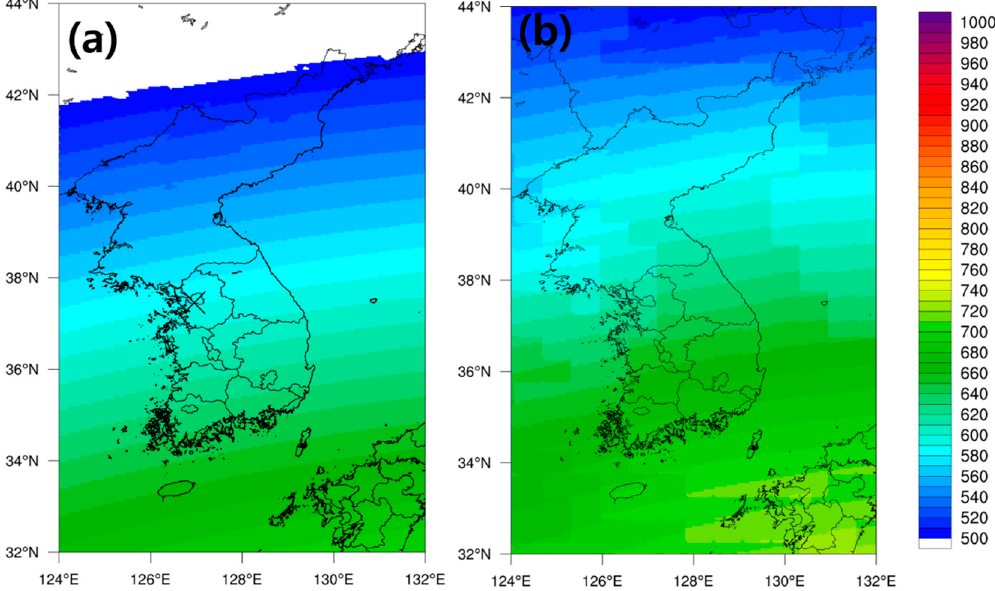
Figure 13. Horizontal distribution of clear sky global horizontal irradiance (GHI) from the control run ( a ) and S5 run ( b ) at 1200 Local Standard Time (LST) on Julian day 33 (2 February 2021).